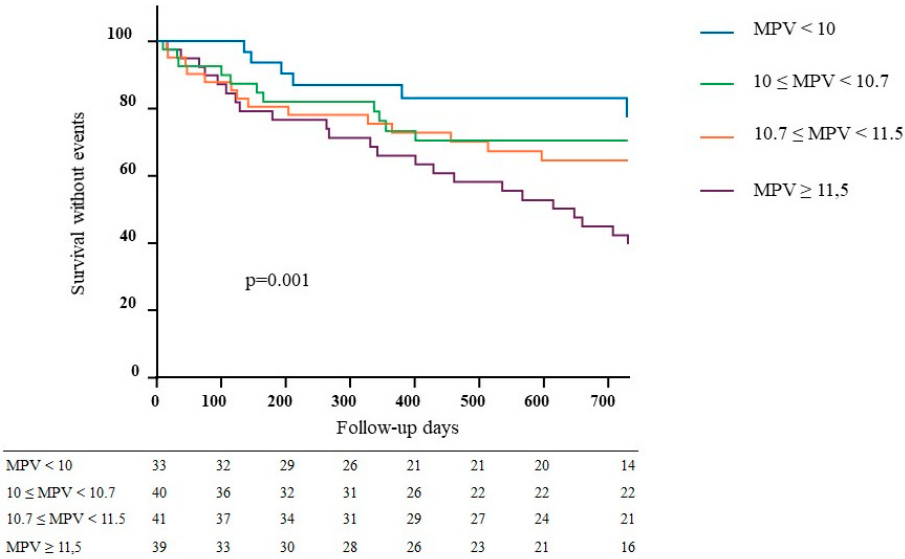
Figure 2. Kaplan–Meier plots of vascular access events: 54 events occurred during the follow-up with group 1: 18% n = 6 / 33 patients; group 2: 27% n = 11 / 40 patients; group 3: 34% n = 14 / 41 patients; and group 4: 59% n = 23 / 39 patients.